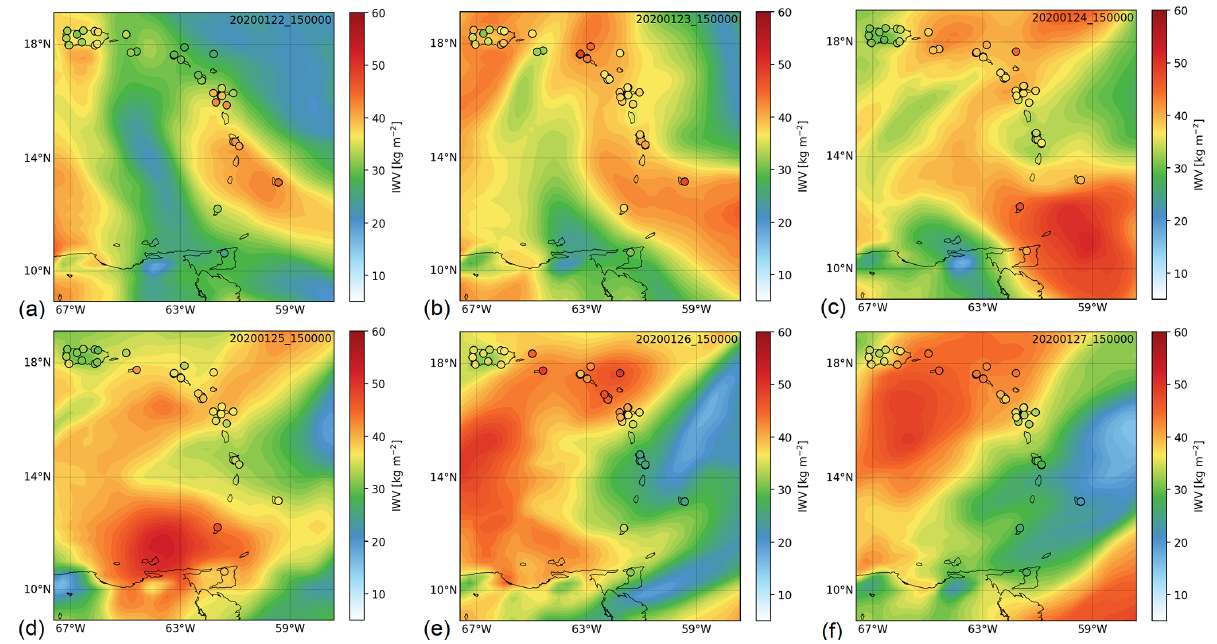
Figure 14. IWV fields from ERA5 reanalysis (background) and GNSS (circles) at 15:00UTC on each day between 22 and 27 January 2020 (see text insert in each